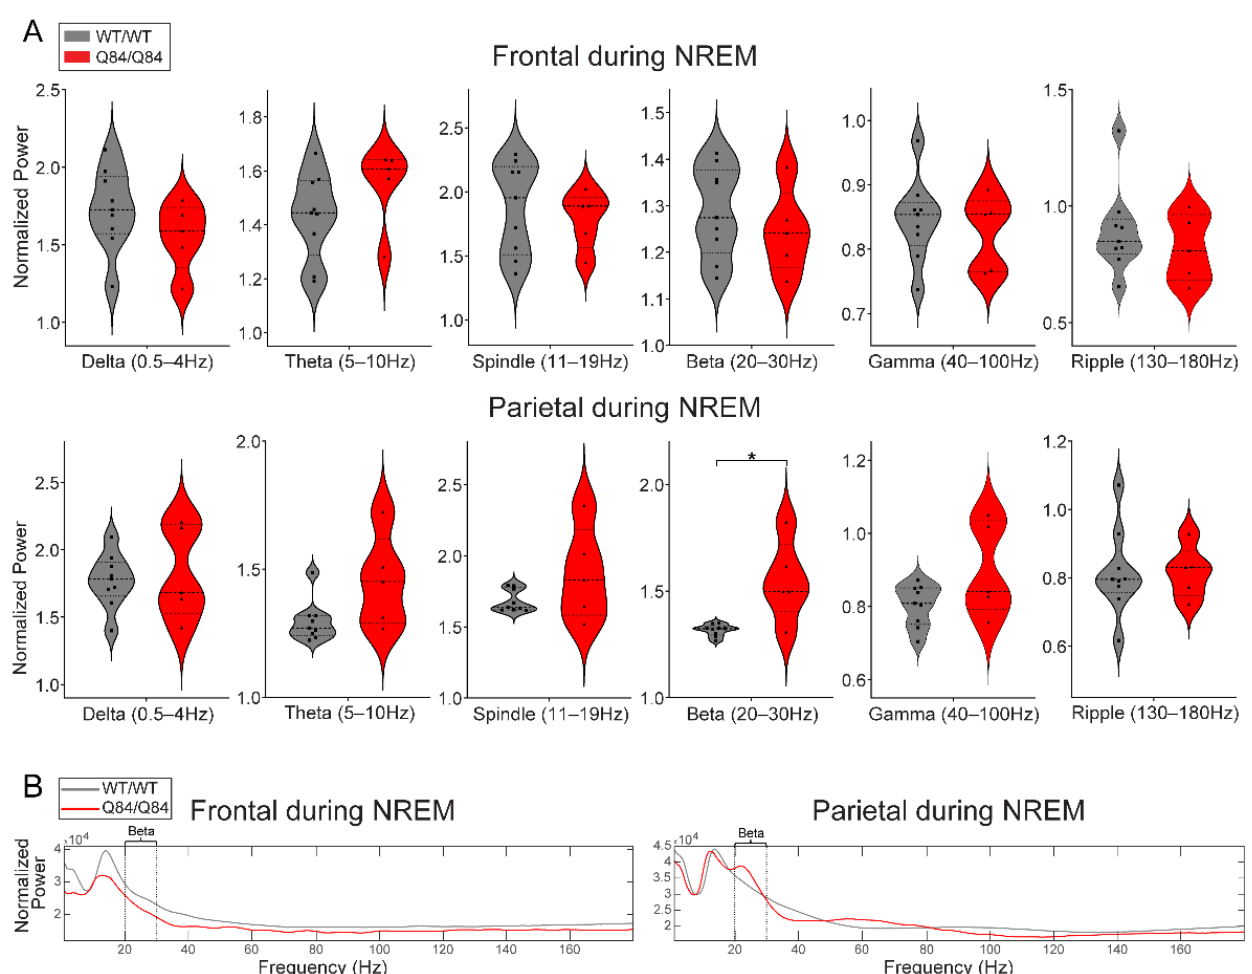
Figure 4. In NREM sleep, homozygous Q84/Q84 mice show increased parietal beta power. ( A ) Homozygous Q84/Q84 mice (red, n = 5) show higher oscillatory power compared to the wild ‐ type WT/WT (grey, n = 9) in the parietal beta band power during NREM. In violin plots, squares and triangles represent individual values for wild-type and homozygous mice, dashed lines display the median, and dotted lines show quartiles. ( B ) The total power averaged across all seconds of NREM for each genotype is plotted for better visualization. Trends towards reduced delta and spindle power can be appreciated – both thalamocortical rhythms. All plots display results that come from the 12 h lights-on period (zeitgeber time (ZT) 0–12) and power is normalized by dividing over the respective frequency’s median value. Statistical difference according to independent t -test or Mann–Whitney test. (red: homozygous Q84/Q84 mice ( n = 5), grey: wild-type WT/WT mice ( n = 9)) NREM: non-rapid-eye movement sleep, * p < 0.05.